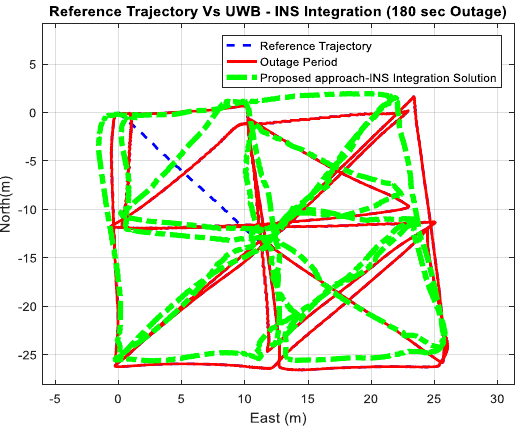
Figure 7. UWB-INS integration performance compared against reference trajectory for full GNSS Signal outage (3 minutes)